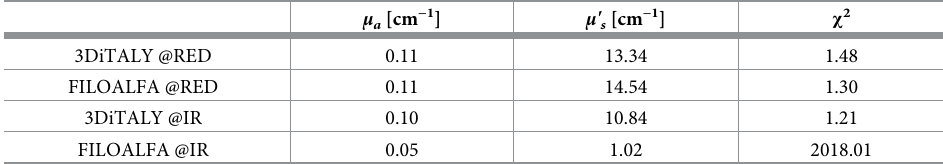
Table 2. Average absorption ( μ a ), reduced scattering ( μ ’ s ) coefficients and χ 2 calculated over 30 repeated DTOFs acquired at 689 nm (RED) and 828 nm (IR) with two PLA probes.